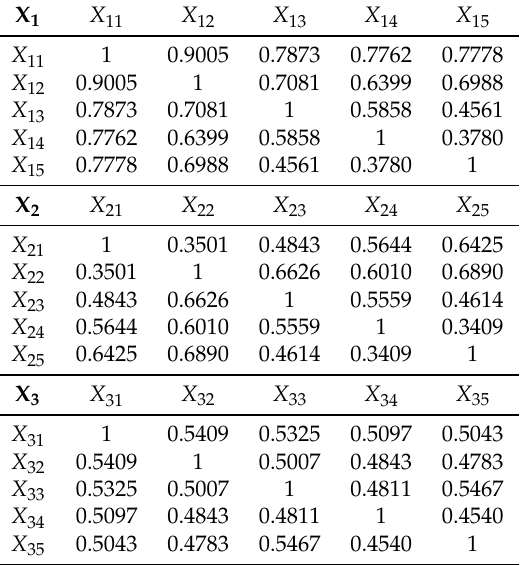
Table 2. Correlation matrix with the simulated multivariate data.Note: X 1 , X 2 and X 3 are vectors. X 1 X 11